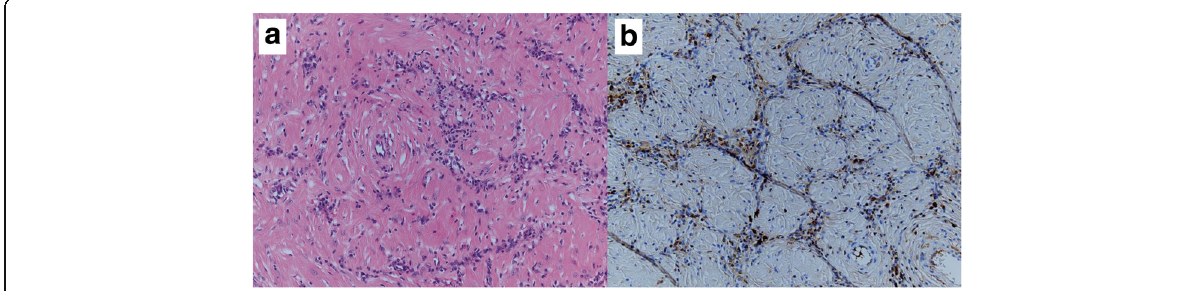
Fig. 5 Histological findings and immunohistochemical studies. a H&E stain (×20) shows a whorled bundle of collagen fiber and hyalinized stroma with hypocellular spindle cells. Infiltration of inflammatory cells is observed along small vessels. b IgG4 immunohistochemical stain (×20) shows numerous IgG4-positive plasma